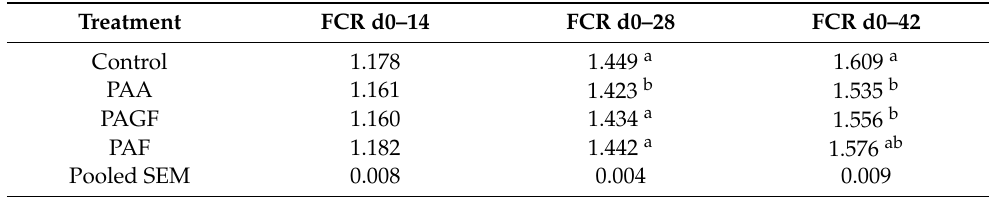
Table 2. Feed conversion ratio (FCR) of broilers fed either a control diet or control diet with 5 mg/bird/day of phosphatidic acid added from d0–42 (PAA), d15–42 (PAGF), d29–42 (PAF). Treatment FCR d0–14 FCR d0–28 Control 1.178